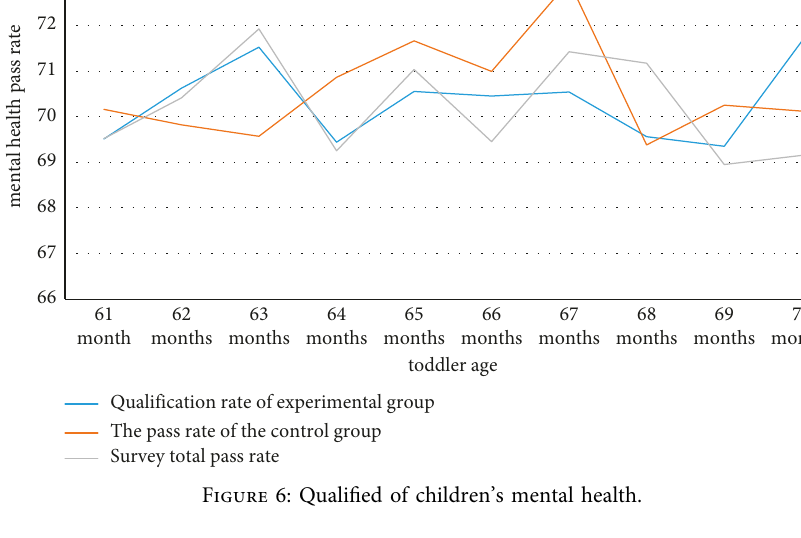
Figure 6: Qualified of children’s mental